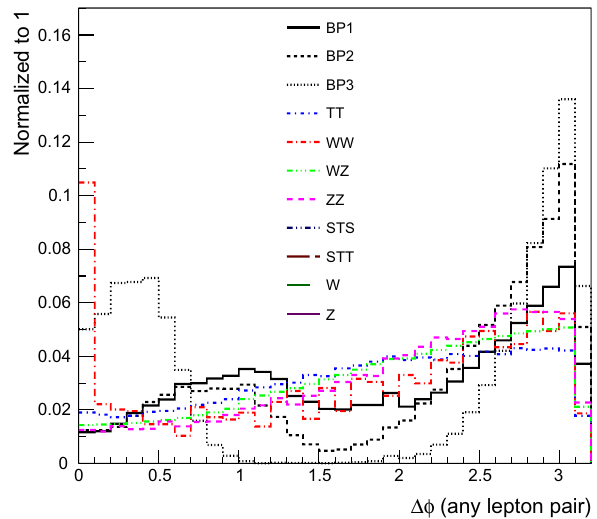
Fig. 9 The distribution of (cid:13)φ between any lepton pair in signal ( (cid:2)(cid:2) H (cid:2)ν H ) and background events. Small background samples have been eliminated